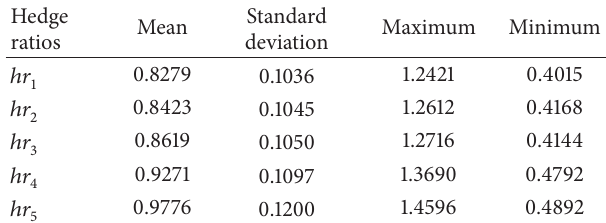
Table 4: Statistical description of time-varying hedge ratios of futures contracts with different maturities.